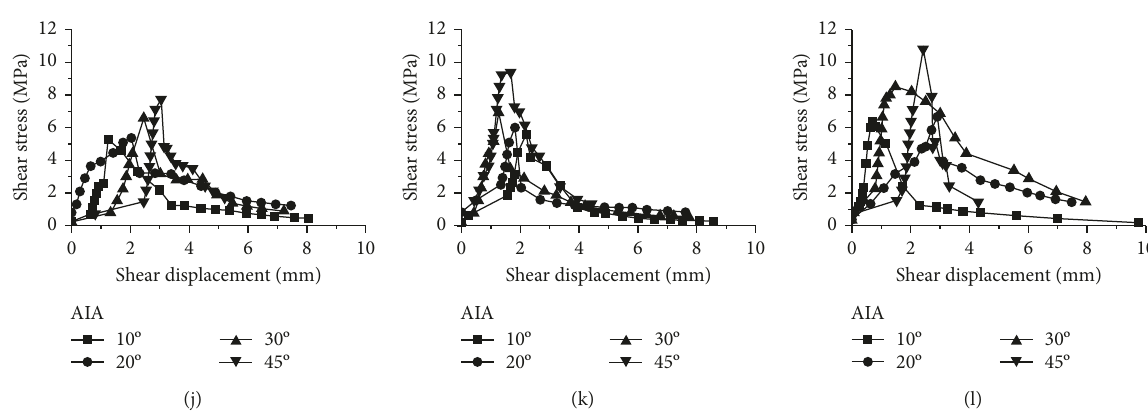
Figure 11: Relation between shear strengths and displacements for the discontinuities with type I. (a) AIA (b) AIA 10 ° and SD 0 ° ; (c) AIA 20 ° and NS 2.04MPa; (d) AIA 20 ° and SD (cid:31) (cid:31) (cid:31) (cid:31) (cid:31) 45 ° and NS 2.04MPa; (h) AIA 45 ° and SD 0 ° ; (i) NS SD 0 ° ; (g) AIA (cid:31) (cid:31) (cid:31) (cid:31) (cid:31) (k) NS 2.04MPa and SD 0 ° ; (l) NS 3.06MPa and SD 0 ° (cid:31) (cid:31) (cid:31) (cid:31)